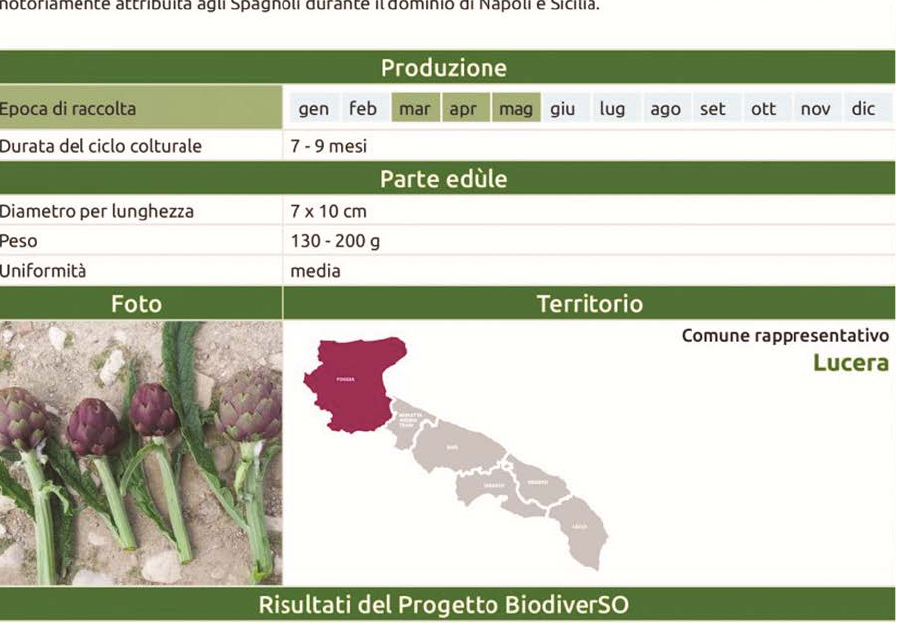
Figure 5. Synoptic sheet for ‘Carciofo di Lucera’, generated by the management system of the project BiodiverSO (in Italian) and extrapolated from [32]. The upper part of the image contains the name of the local variety (“di Lucera”) and a description: “The Carciofo di Lucera is cultivated in small gardens by old farmers, using traditional farming systems. The globe artichoke cultivation in the town of Lucera might date back to 1200, during the reign of Sicily of the emperor Frederick II, centuries before the Spanish dominion, to which the introduction of this crop is often attributed in southern Italy”. Other information present in this sheet is referred to (i) production: harvest time (March to May), duration of the crop cycle (7–9 months); (ii) edible part: diameter × length (7 × 10 cm), weight (130–200 g), uniformity (average). At the bottom, a picture of four artichokes (left) and the territory (right) where this landrace was found (the Puglia Region, and, in red, the province of Foggia), with the representative municipality: Lucera town.